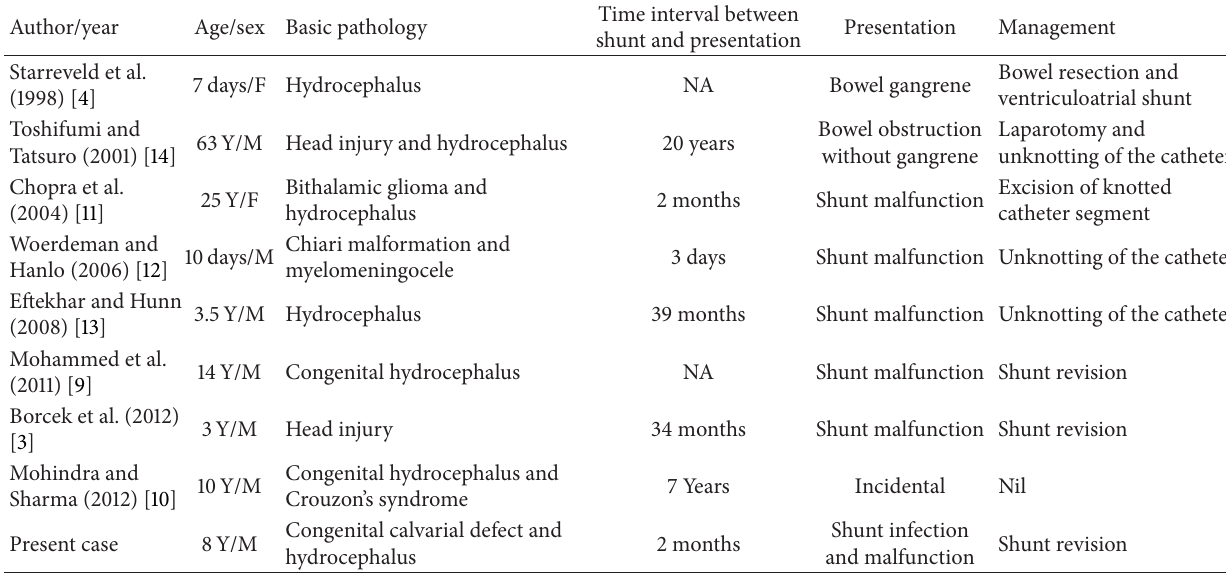
Table 1: Summary of reported cases of peritoneal catheter knot